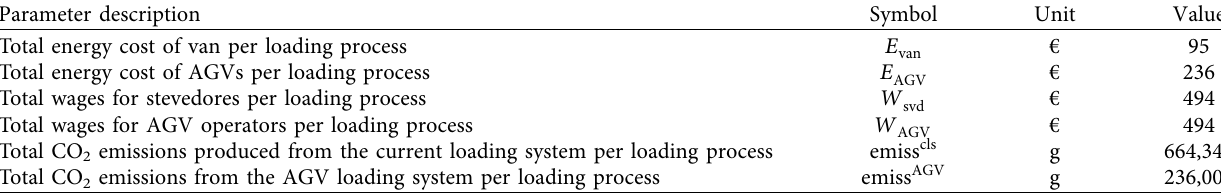
Table 4: Intermediate parameters calculated using equations (1)–(4), (14) and (15).